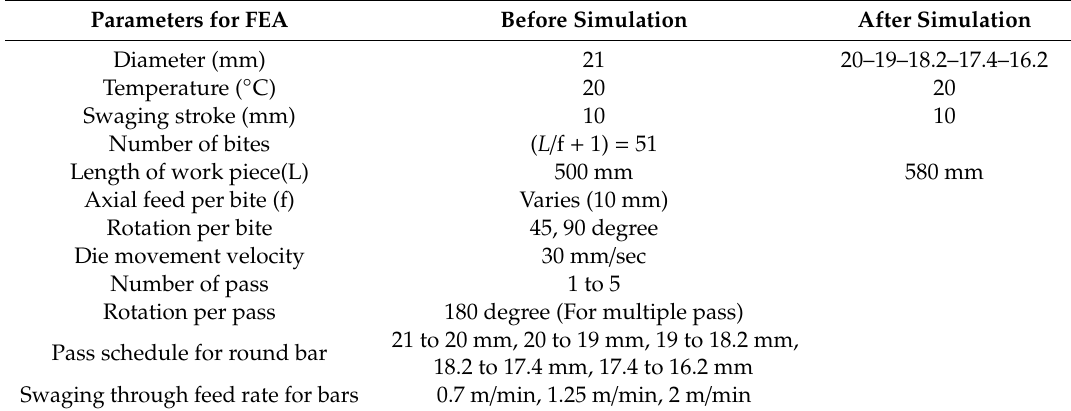
Table 1. List of parameters used in the finite element modelling (FEM) simulation of the swaging process. Parameters for FEA Before